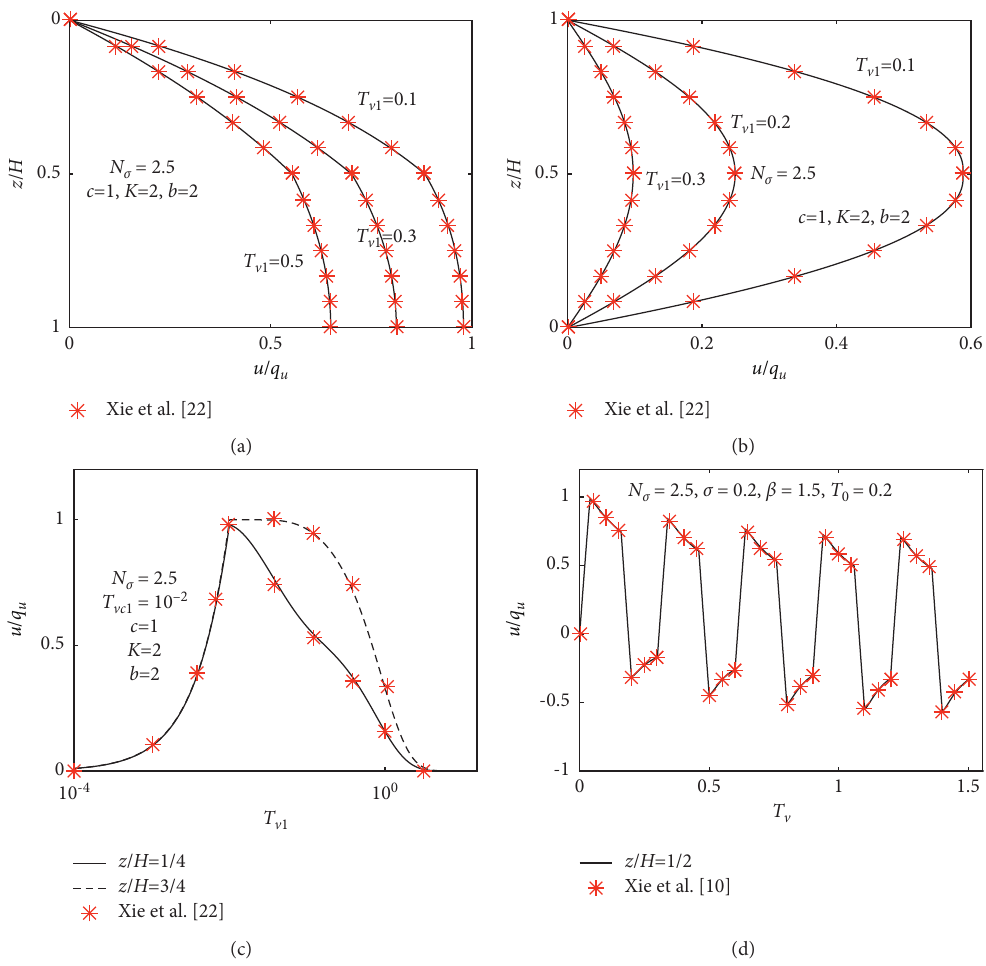
Figure 5: Comparison between the degenerate solutions and the existing solutions.